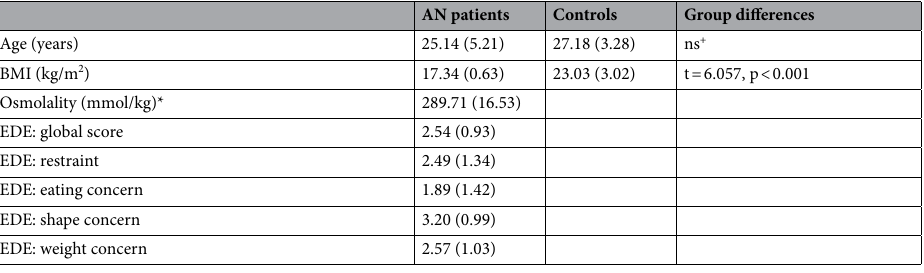
Table 1. Descriptive statistics: *Osmolality index expressed in milliosmoles/kg. Mean (standard deviation) and group differences for age and BMI are shown. Average osmolality index, EDE’s global score, restraint, eating concern, shape concern and weight concern subscales score are reported for individuals with AN only. EDE, Eating Disorder Examination. + p >